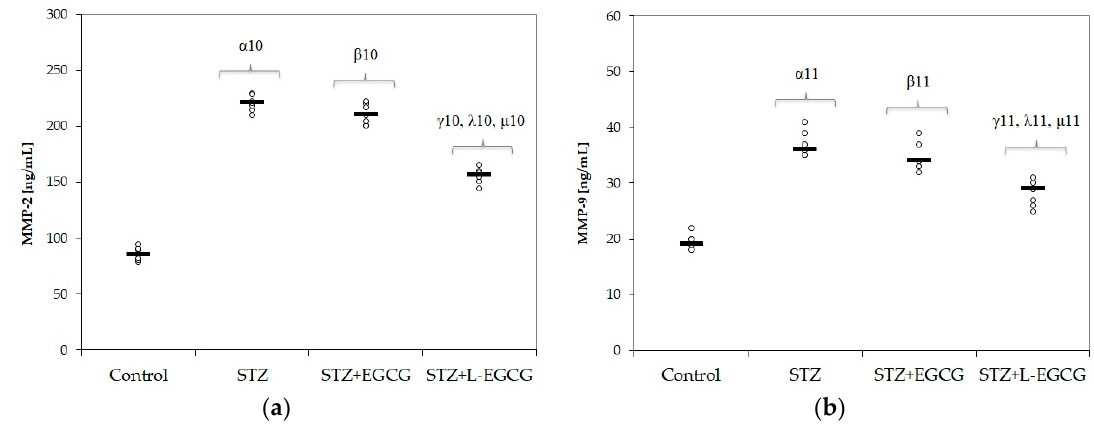
Figure 4. Distribution of matrix metalloproteinase (MMP): ( a ) MMP-2 and ( b ) MMP-9 on all study groups (7 rats/group). STZ = streptozotocin control; STZ + EGCG = STZ and EGCG solution i.p. as pretreatment; STZ + L-EGCG = STZ and liposomal EGCG i.p. as pretreatment. The symbol–number codes correspond to the p -values < 0.05 as follows: α —STZ compared to control; β —STZ + EGCG compared to control; γ —STZ + L-EGCG compared to control; λ —STZ + L-EGCG compared to STZ; µ —STZ + L-EGCG compared to STZ + EGCG.